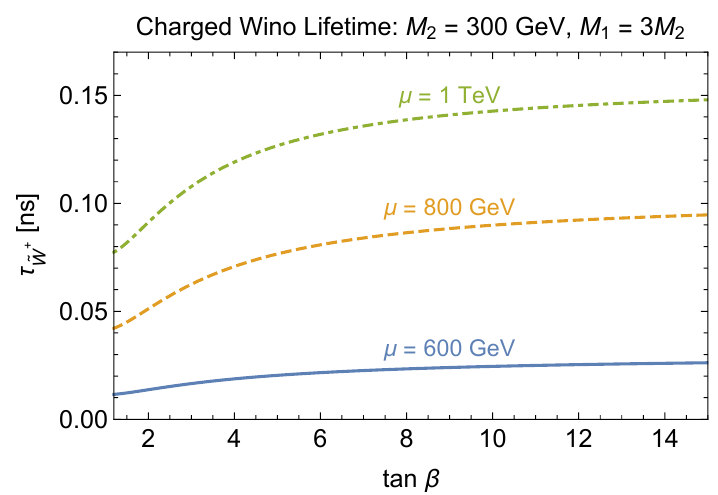
Figure 6 . Dependence of the charged wino lifetime on tan (cid:12) in a scenario with mostly-wino LSP. We take M 1 = 3 M 2 , as in AMSB, and (cid:12)x M 2 = 300 GeV. We have plotted three di(cid:11)erent choices